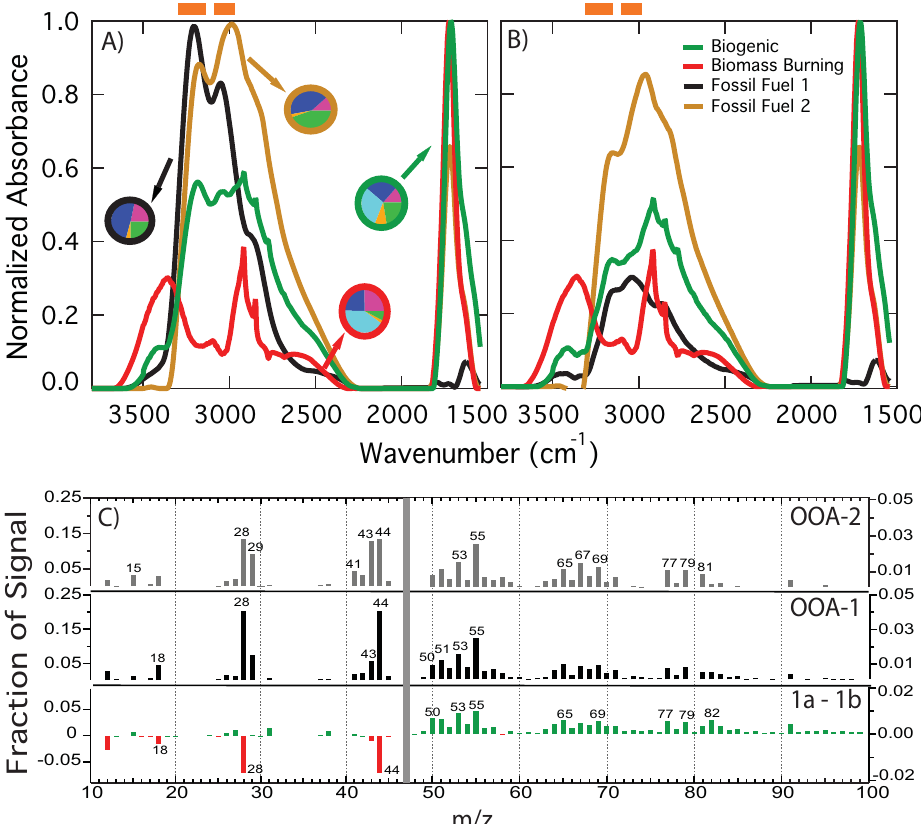
Fig. 4. Normalized FTIR and AMS spectra from the 4-factor (FPEAK=0, seed=1) and 3-factor (FPEAK= − 0.4, seed=1) PMF solutions. (A) FTIR factors: FFC1 FTIR (black), FFC2 FTIR (tan), BB FTIR (red), and BIO FTIR (green). Pies show average organic functional group composition for each factor: alkane (blue), alcohol (pink), amine (orange), carbonyl (teal), and carboxylic acid (green). Factor spectra include organics and ammonium. (B) FTIR factor spectra after subtraction of ammonium absorbance so that only organic absorbance is shown (factors were smoothed by a 5-point box algorithm). Orange bars on top denote region of ammonium absorbance. (C) Normalized mass spectra for the 3-factor PMF solution: OOA-1 AMS , OOA-2 AMS , and the difference mass spectra of OOA-1a AMS and OOA-1b AMS . Vertical grey bar indicates change in axis for fragments greater than m / z